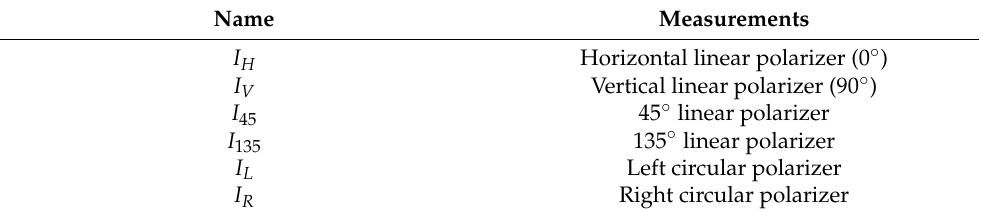
Table 1. Irradiance measurements I